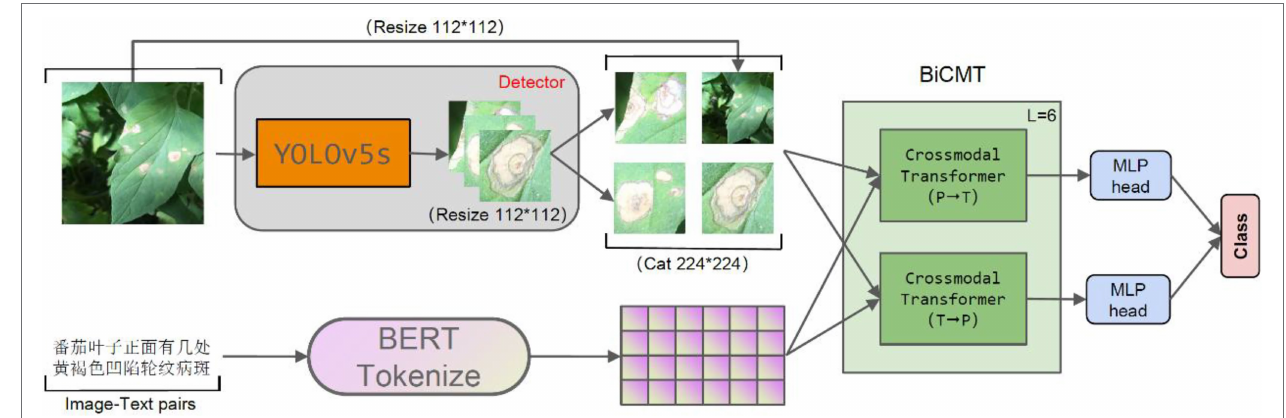
FIGURE 1 | The overall network structure. The input of the model is the “image-text pair.” The detector is YOLOv5s, which is used to detect the disease-spot regions in the images. For text descriptions, Token Embeddings are obtained by loading the BERT Chinese pre-training model. BiCMT is a Bidirectional Cross-Modal Transformer; the two MLP heads of the last BiCMT layer are extracted for classification